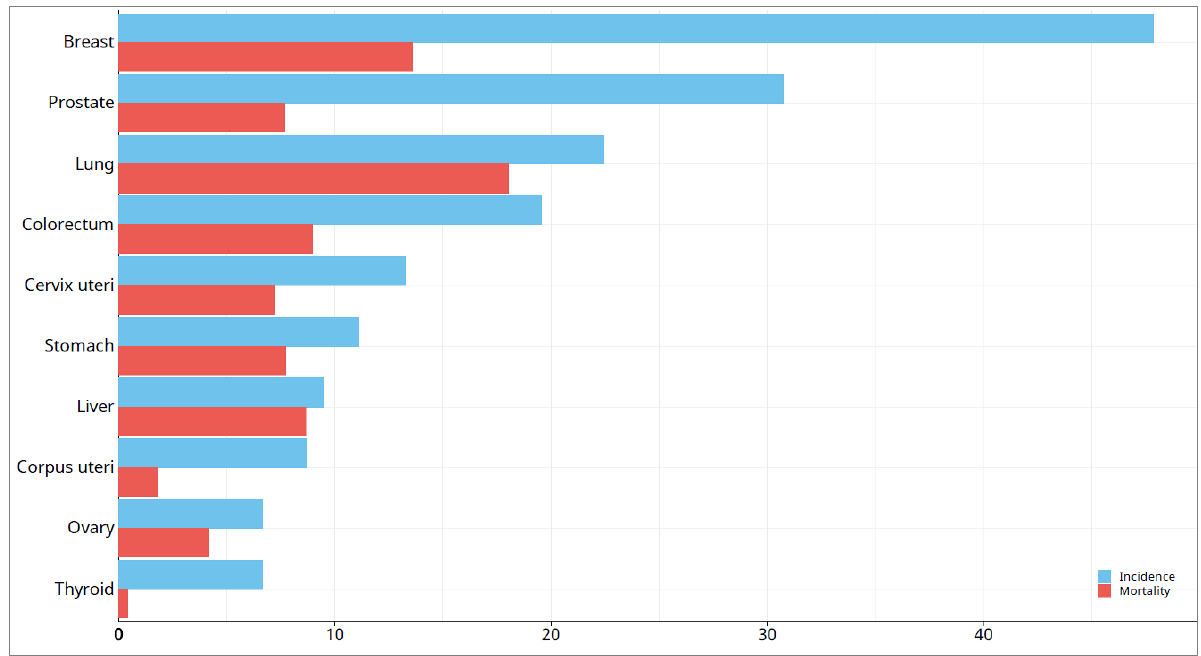
Figure 1. Estimated age-standardized incidence and mortality rates in 2020, worldwide, both sexes, all ages. Red bars indicate mortality, blue bares are incidence